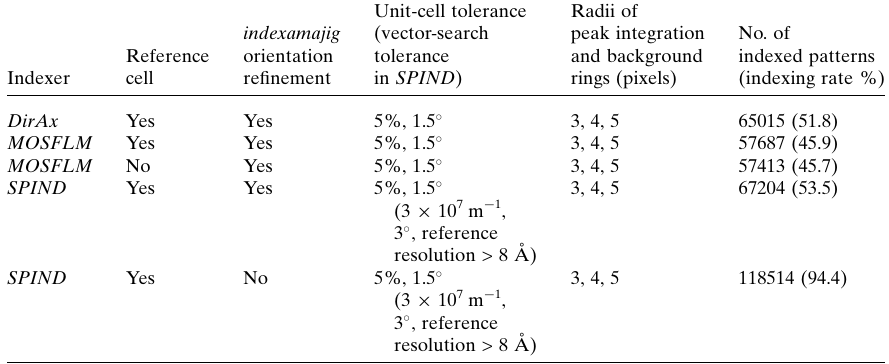
Table 2 Parameters for auto-indexing of DOR SFX data using indexamajig , calling DirAx , MOSFLM and SPIND as subroutines.